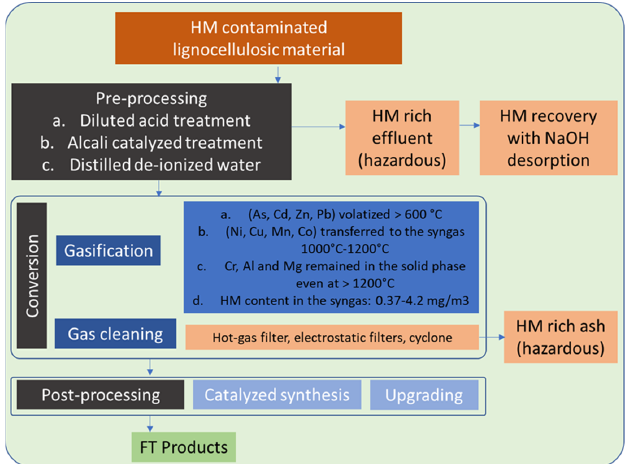
Figure 11. CVC2–BtL via gasification. Adapted clean value chain.